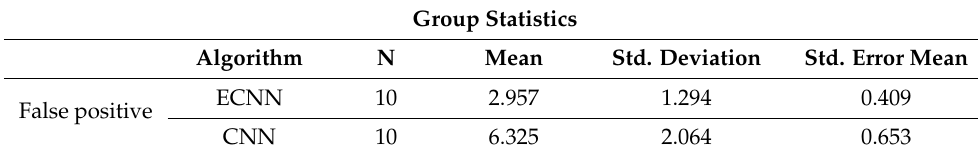
Table 9. Independent-sample test significance computation between ECNN and CNN algorithms for false positive.